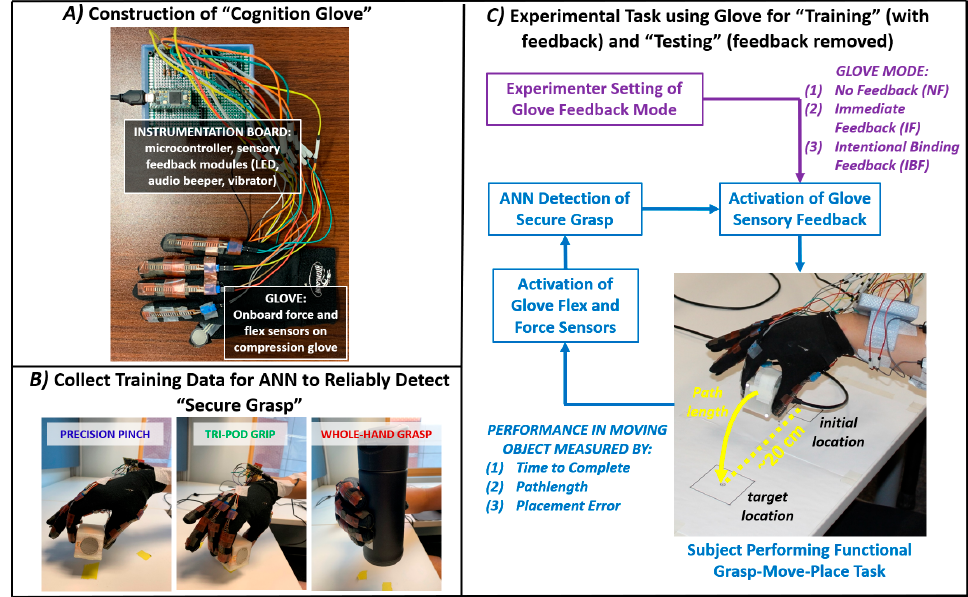
Figure 1. ( A ) Cognition glove hardware. Physical components, including instrumentation, of glove worn by user, ( B ) Training. Data collected to train artificial neural network (ANN) to identify secure grasp onto object across three grip types, ( C ) Functional task. Flow diagram of experiment to verify improvement in performance of grasp-move-place task when receiving feedback from glove if secure grasp achieved.